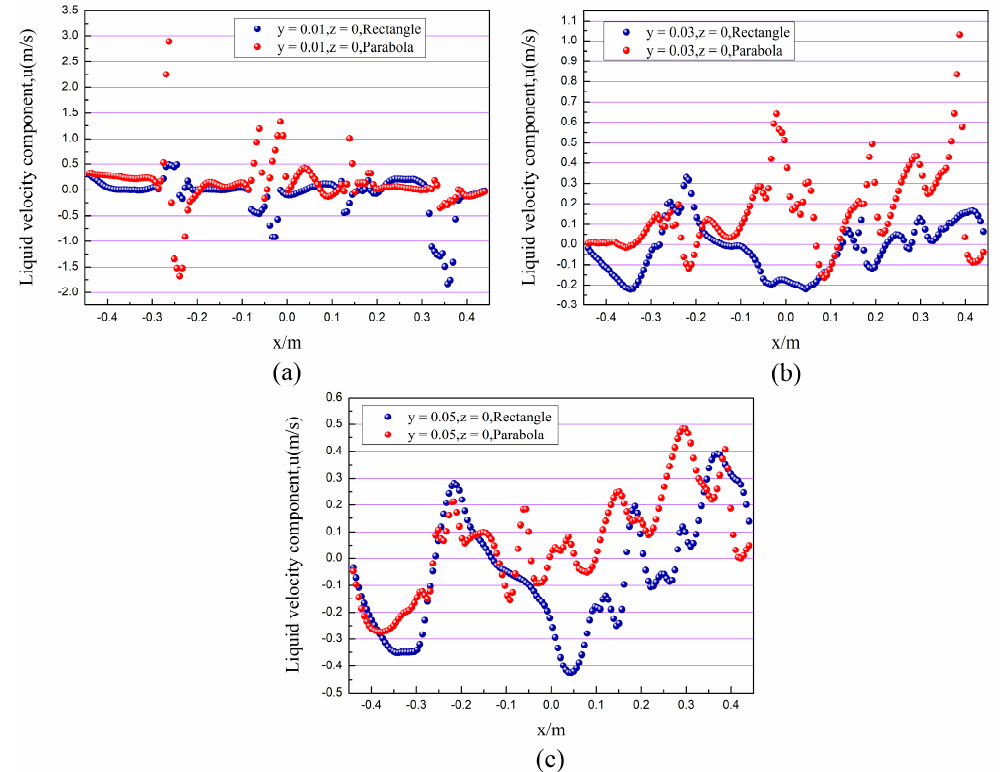
Figure 18. The x –direction–component velocity profiles of the liquid flow field at different elevations: ( a ) y = 0.01 m; ( b ) y = 0.03 m; ( c ) y = 0.05 m.